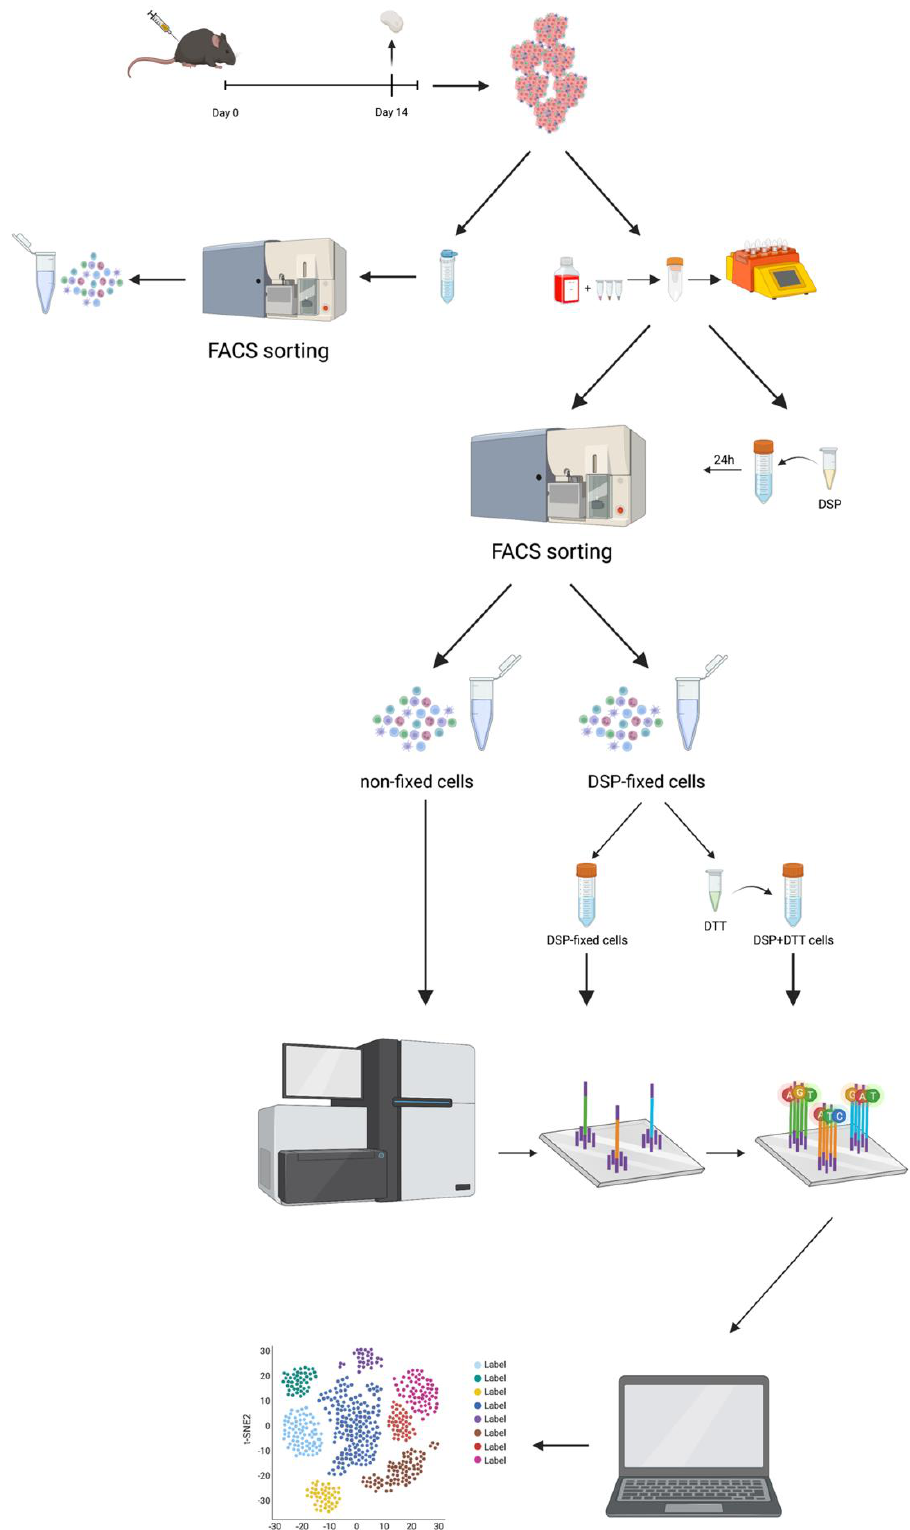
Figure 1. Schematic overview of the tissue processing workflow .